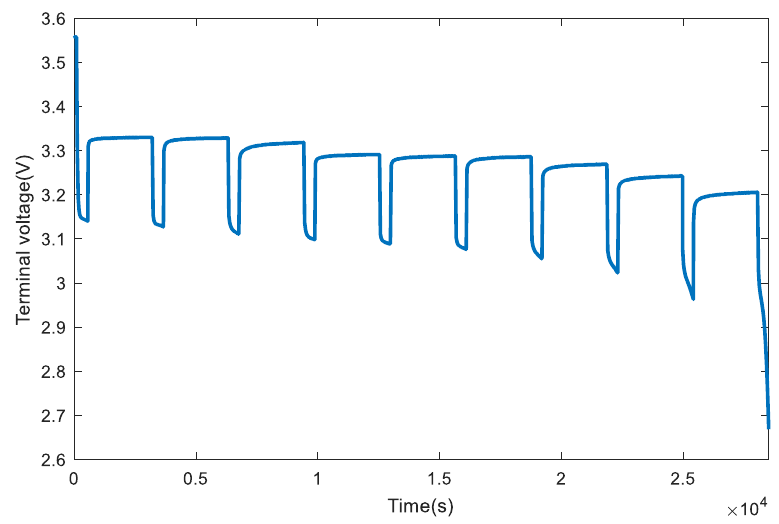
Figure 5. Terminal voltage during discharging pulse test.